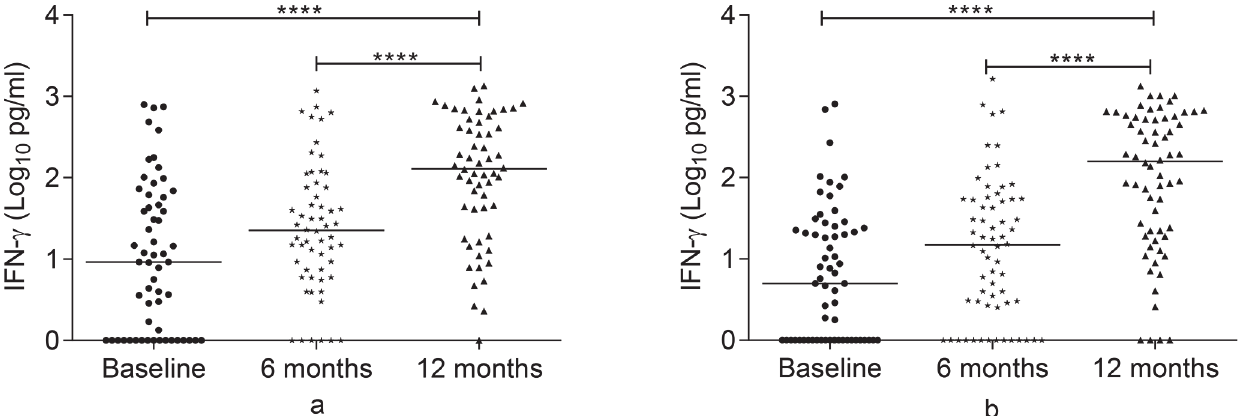
Fig 2. Changes in IFN- γ response to Rv2031 over 12 months in patients and contacts. IFN- γ response over 12 months in patients (a) and contacts (b) following whole blood stimulation with Rv2031 for 48 hours. Filled circles represent baseline levels, filled diamonds represent 6 month levels and filled triangles represent 12 month levels. Results are individual responses and cytokine levels are expressed as log 10 pg/ml. Horizontal bars are medians. Freidman test with Dunn ’ s multiple comparisons was used to compare IFN- γ response over time. **** p < 0.0001.